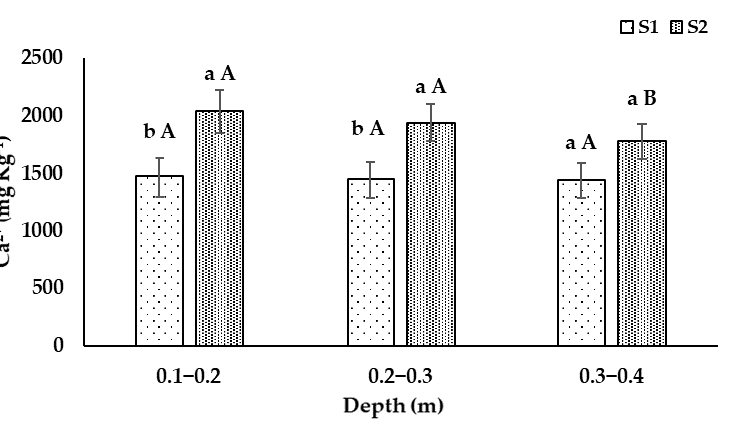
Figure 5. Interaction between depth (0.1 – 0.2, 0.2 – 0.3 and 0.3 – 0.4 m) and soil type (soils S 1 and S 2 ) for soil Ca concentration (mg kg −1 ). Lowercase letters are used for the comparison between the soil type in each depth and uppercase letters are used for the comparison between each type of soil and depth.